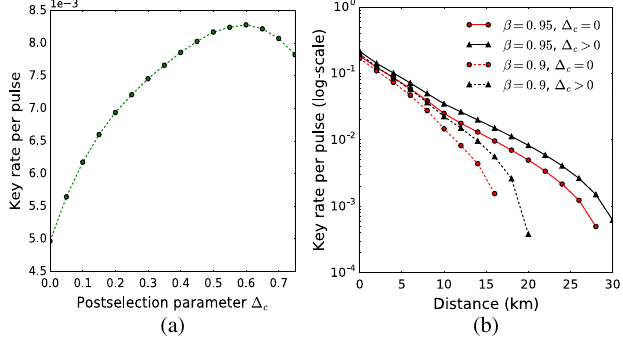
FIG. 5. Secure key rate for protocol 1 (homodyne detection) with postselection. The excess noise is ξ ¼ 0 . 02 , and the coherent state amplitude is α ¼ 0 . 45 . (a) Secure key rate versus the postselection parameter Δ at the distance L ¼ 20 km with the c reconciliation efficiency β ¼ 0 . 95 . (b) Secure key rate versus the transmission distance with or without postselection for two different values of β . Solid lines have β ¼ 0 . 95 , and dashed lines 0 , and have β ¼ 0 . 9 . Lines with (red) circle markers have Δ c ¼ lines with (black) triangle markers have Δ optimized via a c coarse-grained search in the interval [0.5,